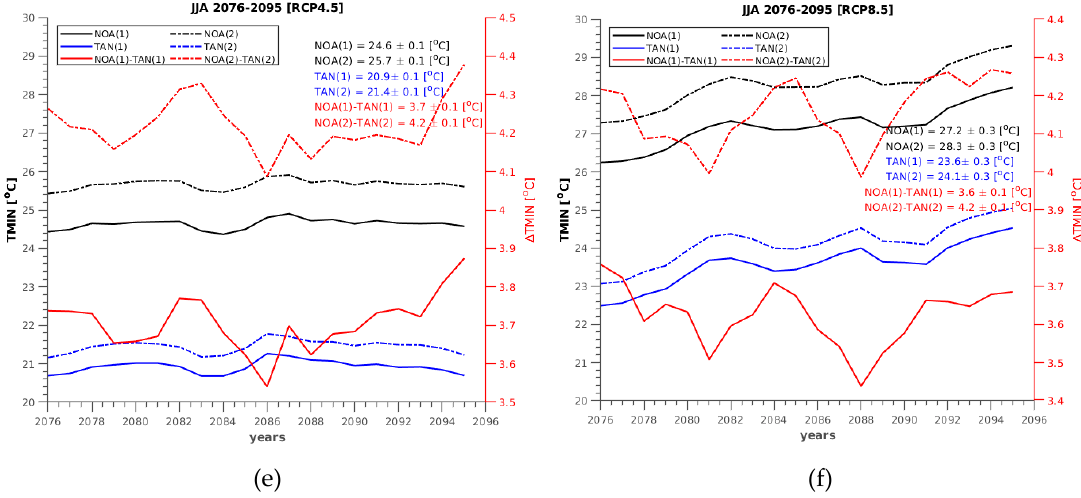
Figure 8. ( a – f ): Summer averaged minimum temperatures (T min ) and UHI min ( Δ T min ) for the near and distant future periods (2046–2065 and 2076–2095) under climate scenarios RCP2.6, RCP4.5, and RCP8.5. For each period and scenario, simulations NOA (1) / TAN (1) are calibrated against the first reference period (1976–1995) under UHI regime UHI_1 and simulations NOA (2) / TAN (2) are calibrated against the second reference period (1996–2015) under UHI regime UHI_2. Averaged mean change with respective confidence interval is given in the figures for each